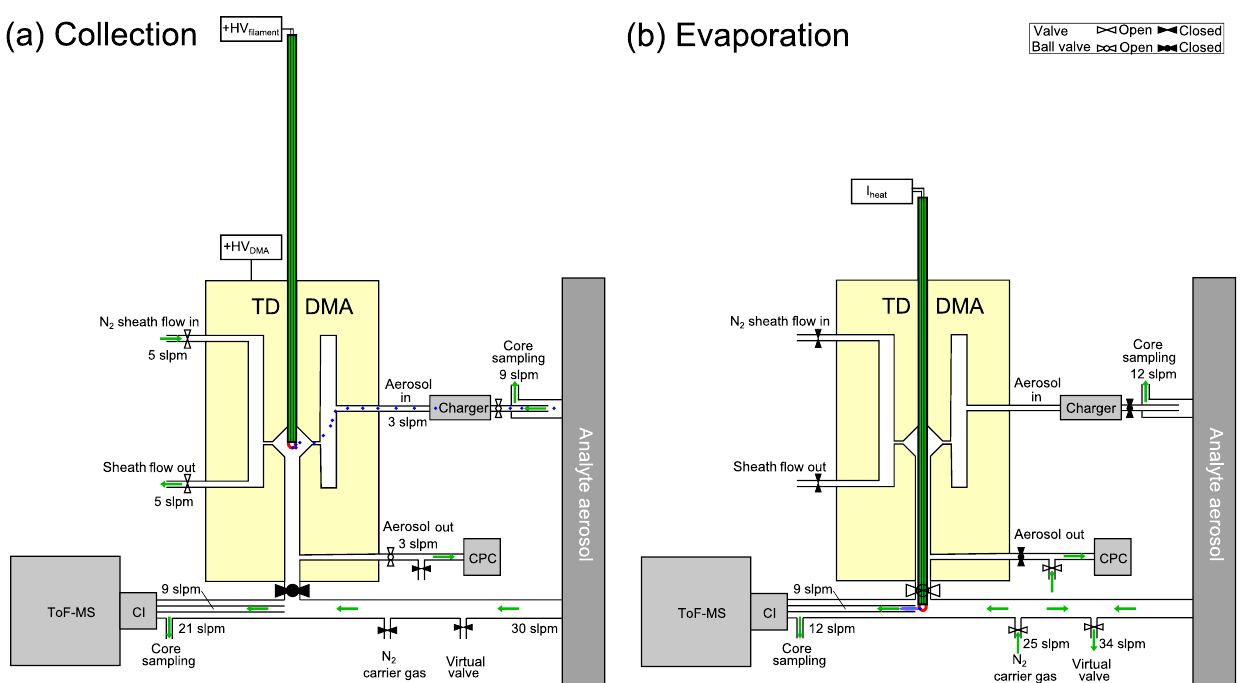
Figure 1. Measurement setup of the TD-DMA with step (a) collection, and (b) evaporation. Filled valves correspond to closed, unfilled ones to open. In step (a) , particles (blue) from the aerosol sample are charged, size selected and collected on a filament (red) inside the DMA unit (yellow). In step (b) , the filament is moved in front of a mass spectrometer and the collected material is evaporated and